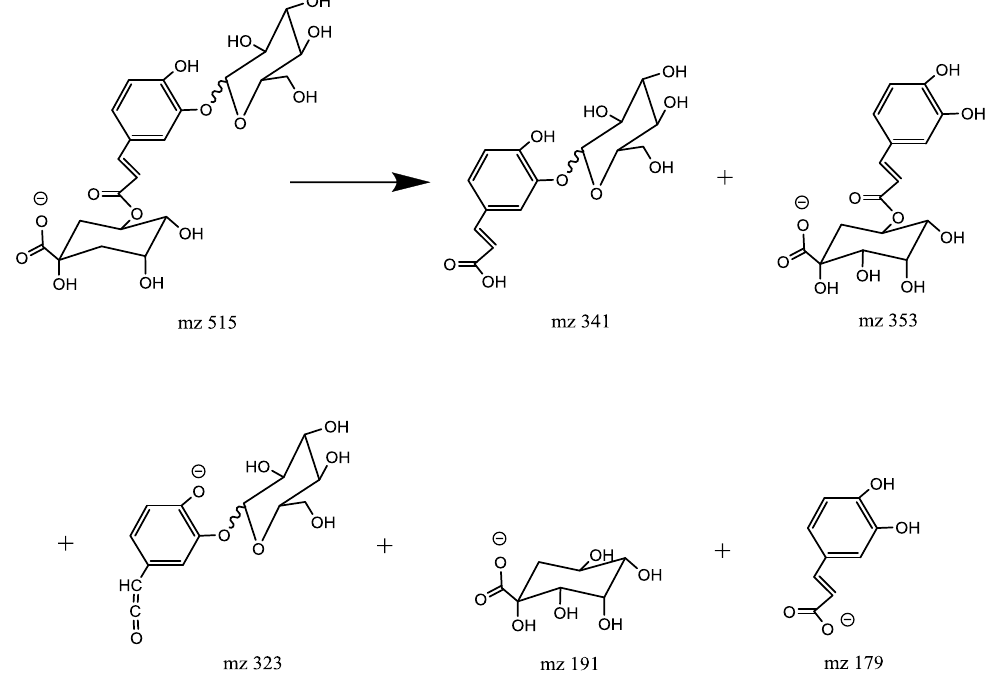
Figure 8. Fragmentation pathways of 5- O -(3′- O -Glucosylcaffeoyl) quinic acid.